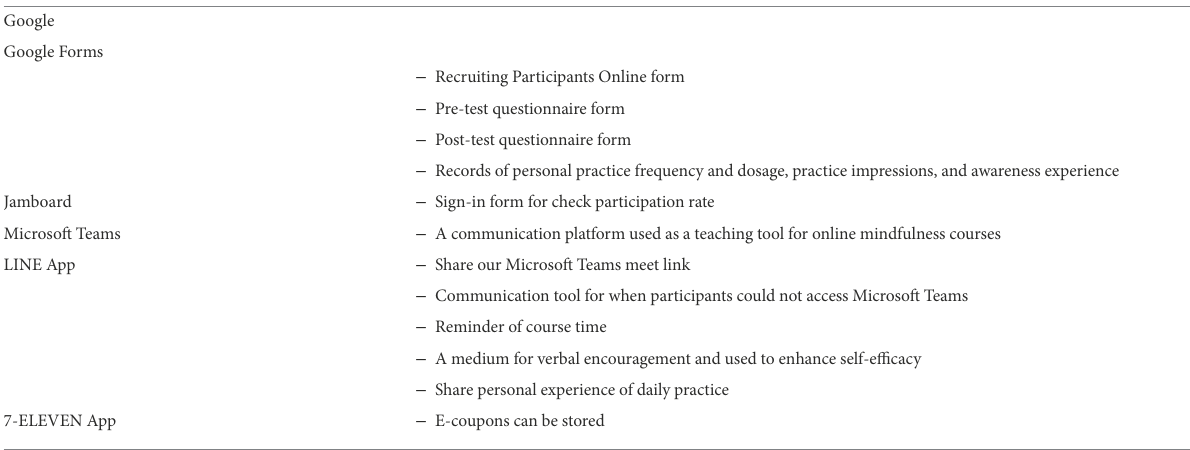
TABLE 1 Web-based collaboration (or interactive) software (or